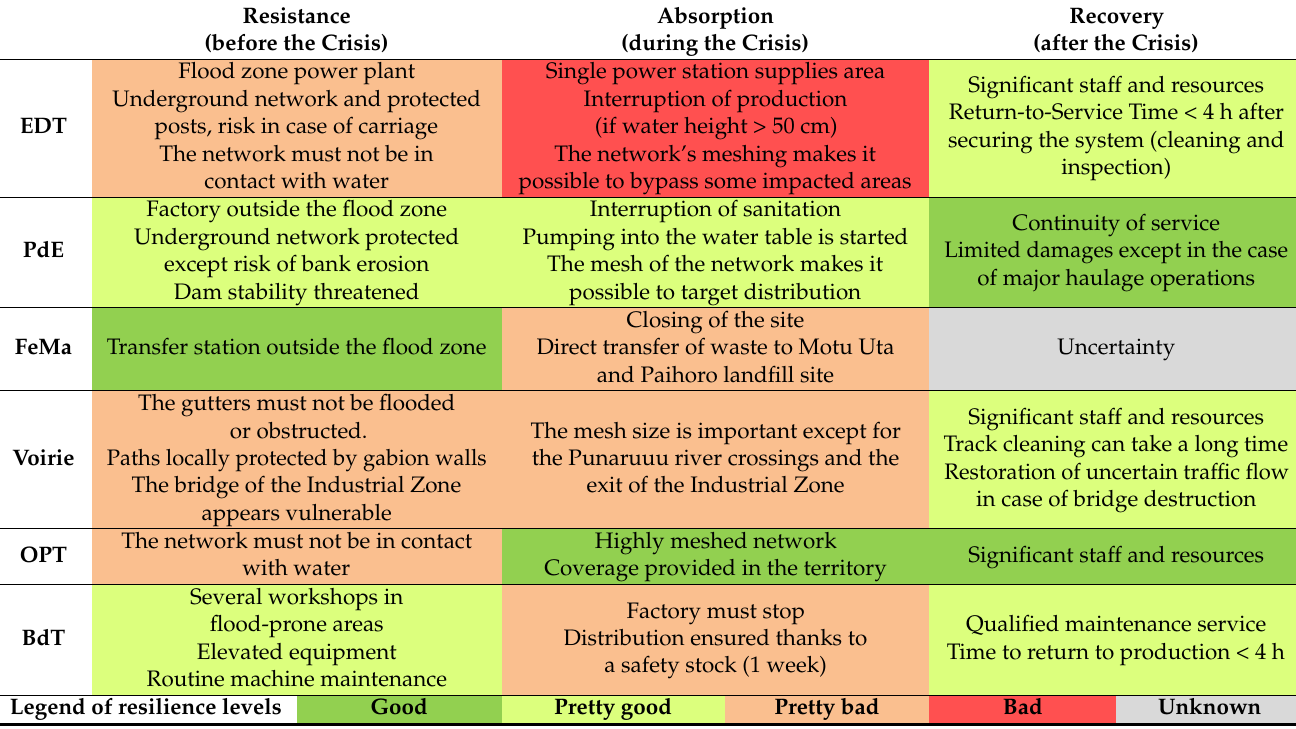
Table 4. Application of the DS3 model and the results of a collaborative study with the urban technical services of the Punaruu valley, in the face of the centennial flood, without taking into account